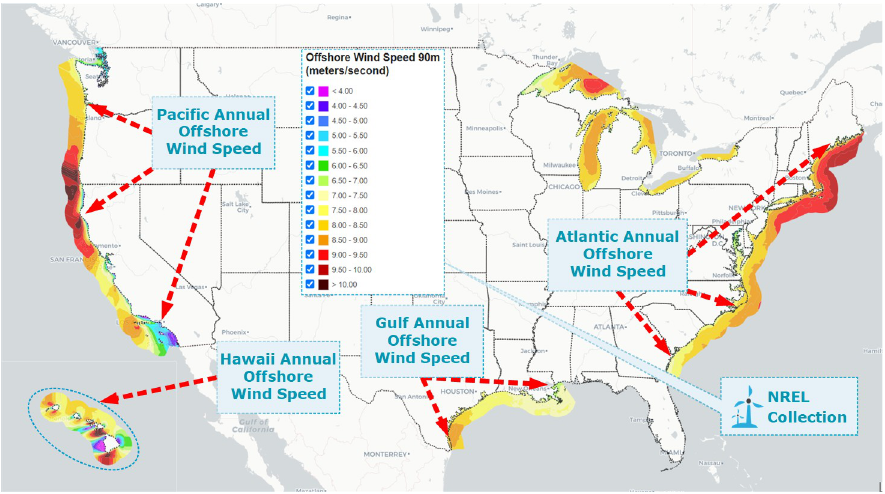
Fig 3. Wind speed is observed on an annual basis in several regions where offshore wind turbines were positioned. The NREL Maps API (https://maps.nrel.gov/) and the Offshore annual wind speed data are utilized to generate a geospatial map of offshore regions.